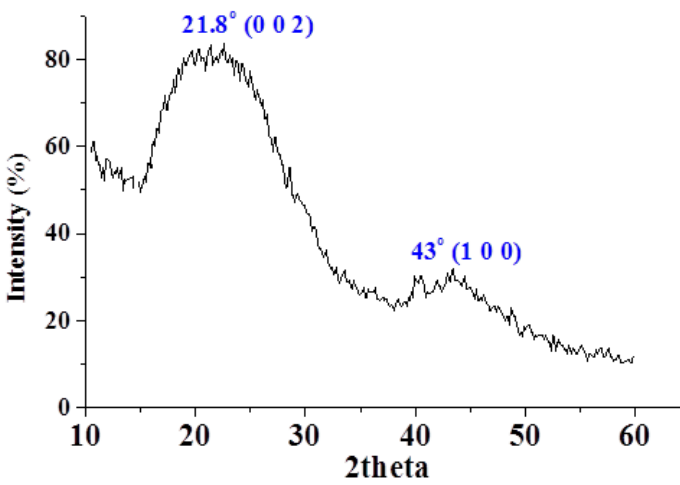
Figure 3. X-ray diffraction pattern of the fresh adsorbent.